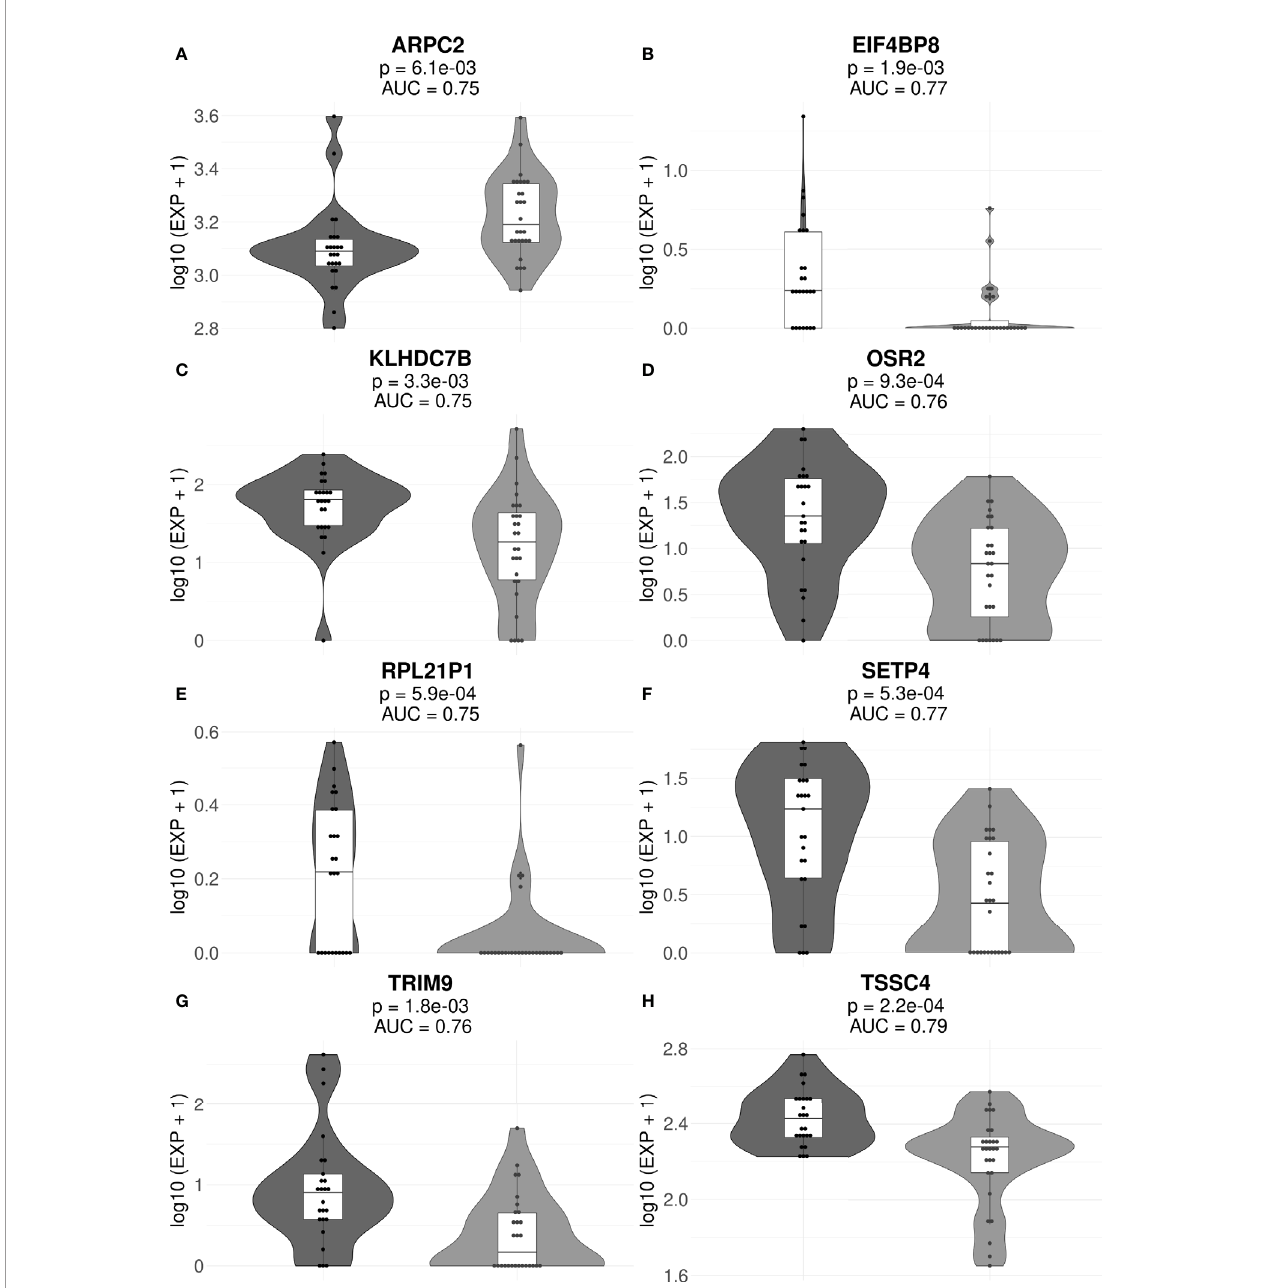
FIGURE 3 | Gene expression levels of genes ARPC2 (A) , EIF4BP8 (B) , KLHDC7B (C) , OSR2 (D) , RPL21P1 (E) , SETP4 (F) , TRIM9 (G) , and TSSC4 (H) in the full cohorts of MM responders and poor responders to PAD/VCD therapy. For every gene, paired t-test p-values and AUC values are shown. Each dot on the graph represents single MM sample. Grey indicates good treatment responders, black — poor